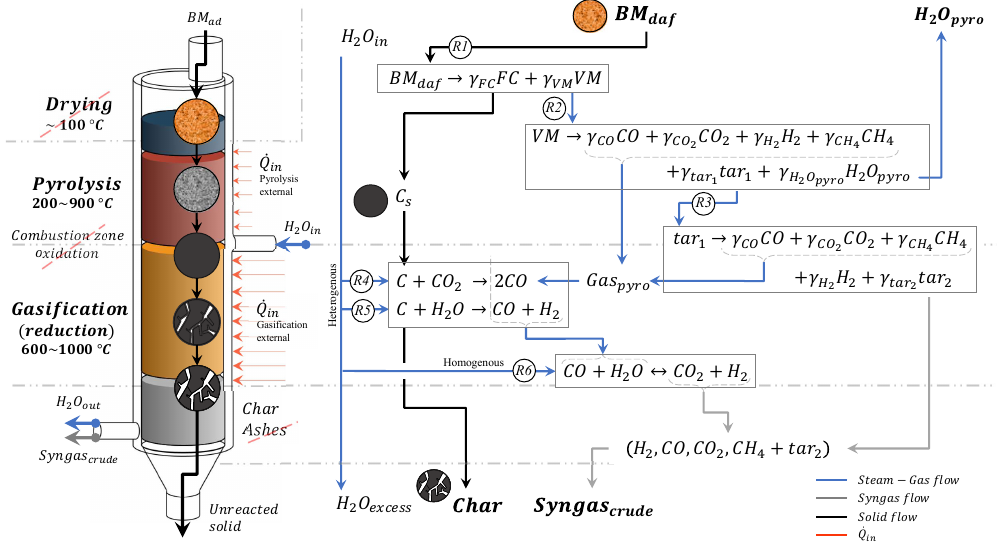
Figure 1. Flowchart of thermochemical conversions via gasification. Left : Mass and energy flow in a downdraft steam gasifier. Right : Reaction mechanism implemented in the current